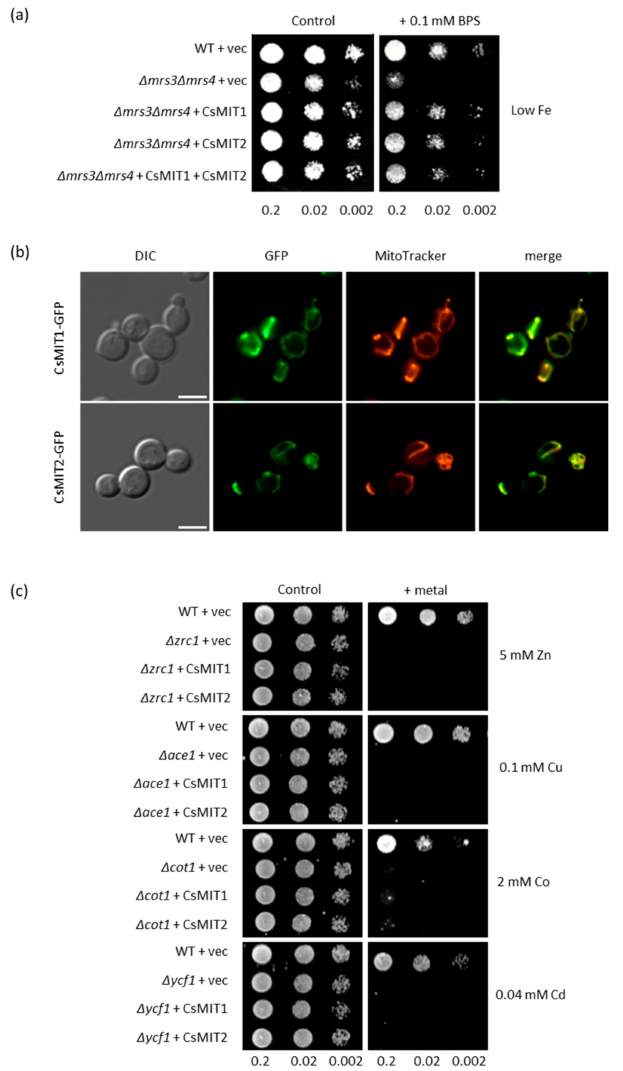
Figure 4. Effect of CsMIT1 and CsMIT2 expression in yeast. ( a ) Representative of serial dilutions corresponding to OD of 0.2; 0.02 and 0.002 of WT and ∆ mrs3 ∆ mrs4 cells transformed with empty vector or vector carrying CsMIT1 or/and CsMIT2 placed onto control SC/Glu-His medium or SC/Glu-His low-Fe medium containing 0.1 mM BPS. ( b ) Localization of CsMIT1 and CsMIT2 in ∆ mrs3 ∆ mrs4 cells. DIC—transmission images of the cells expressing CsMIT1-GFP or CsMIT2-GFP, GFP—GFP fluorescence of the cell, MitoTracker—fluorescence of mitochondria specific marker. The scale corresponds to 5 µ m. ( c ) Representative of serial dilutions corresponding to OD of 0.2; 0.02 and 0.002 of WT and yeast mutants sensitive to various heavy metals. Cells were transformed with empty vector or vector carrying CsMIT1 or CsMIT2 placed onto control SC/Glu-His medium or SC/Glu-His medium supplemented with suitable